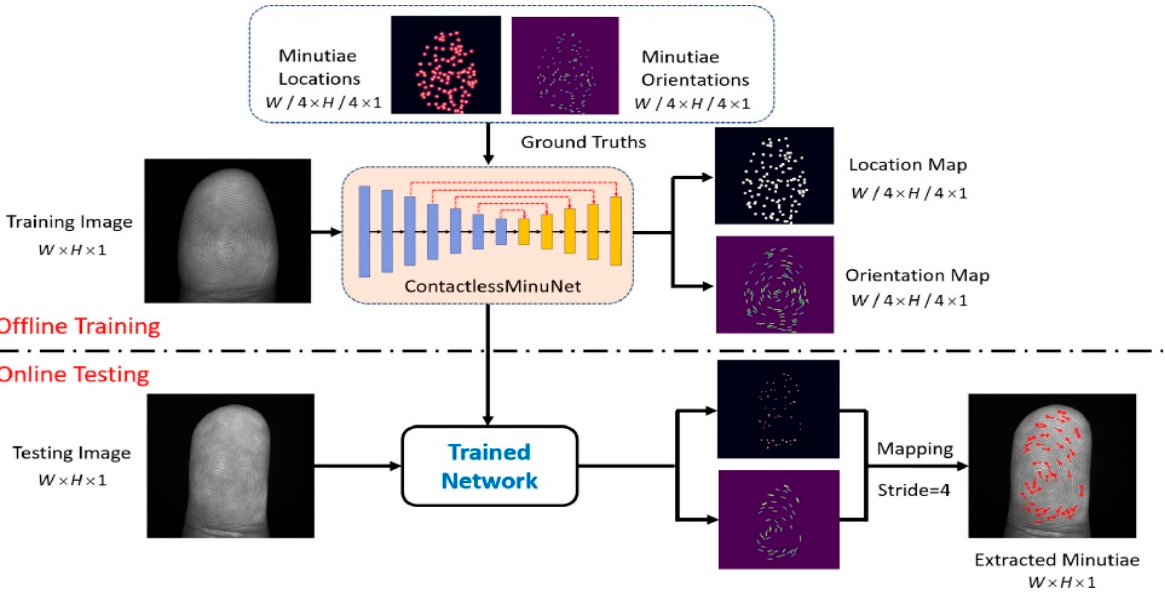
Figure 9. Overview of the minutiae extraction algorithm for contactless fingerprints based on multi- task fully deep convolutional neural network [2].